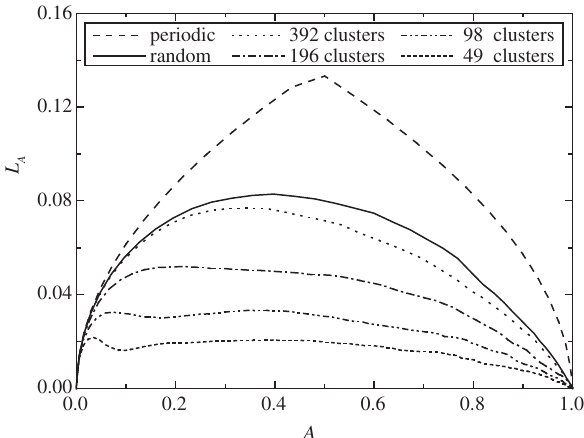
Figure 3. Interfacial area length between recrystallized grains and matrix, L against time, simulated by CA. The maximum in L periodic nuclei arrangement and less pronounced for clusters.